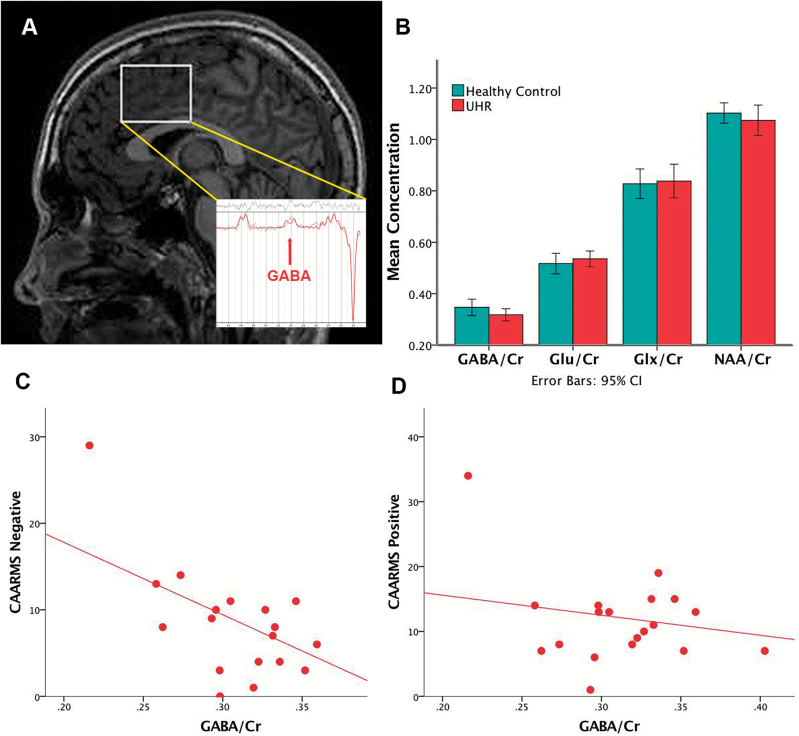
(A) Voxel placement on medial prefrontal cortex (MPFC) and representative sample 1H-MRS spectra. (B) MPFC metabolite levels by group. (C) Scatterplot of the significant association between CAARMS negative symptom severity and GABA/Cr levels (ß = -.556, t = -2.761, R2 = .310, P = .013). (D) Scatterplot of the nonsignificant associations between CAARMS positive symptom severity and GABA/Cr levels (P = .298). Cr, creatine; Glu, glutamate; Glx, glutamate + glutamine; NAA, N-Acetyl-aspartate; UHR, ultra-high risk of psychosis.